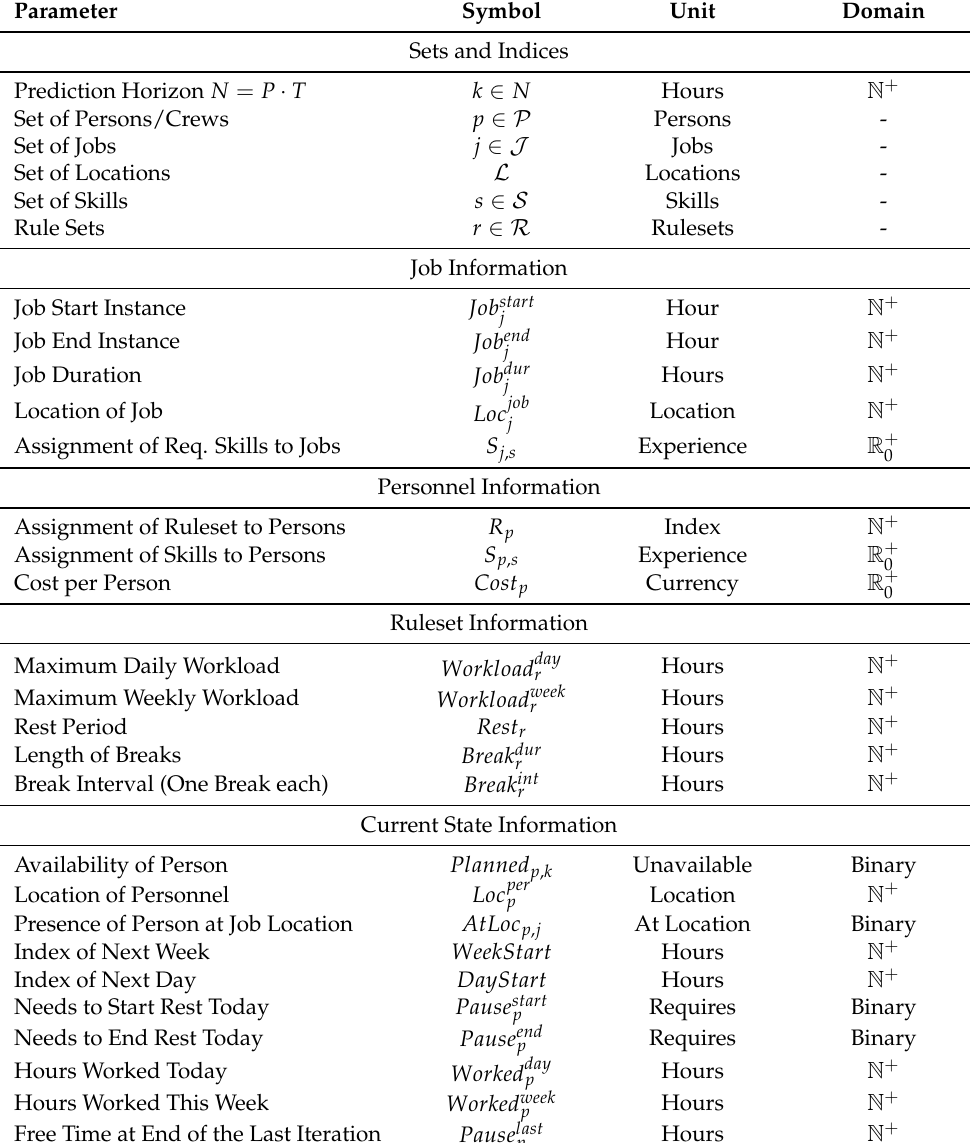
Table 3. Complete state